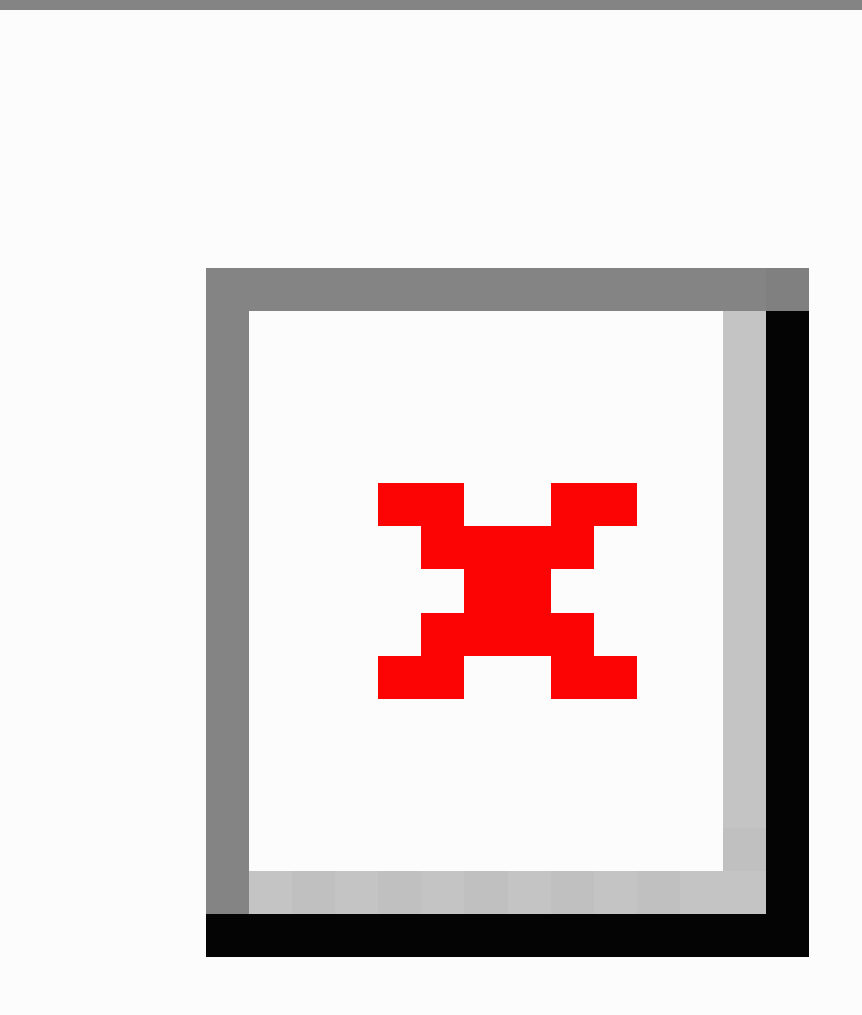
Figure 1. Evolution of the health data management